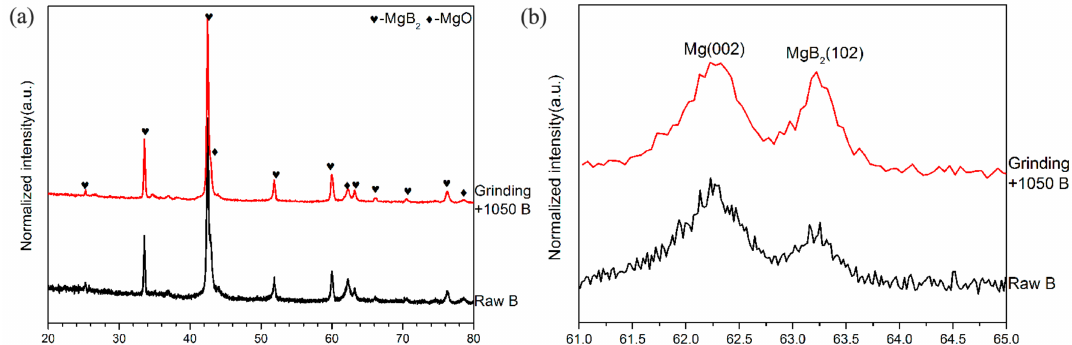
Figure 3. ( a ) XRD results of MgB 2 bulk prepared using B powder with different particle sizes; ( b ) The XRD data in the range between 61 ◦ and 65 ◦